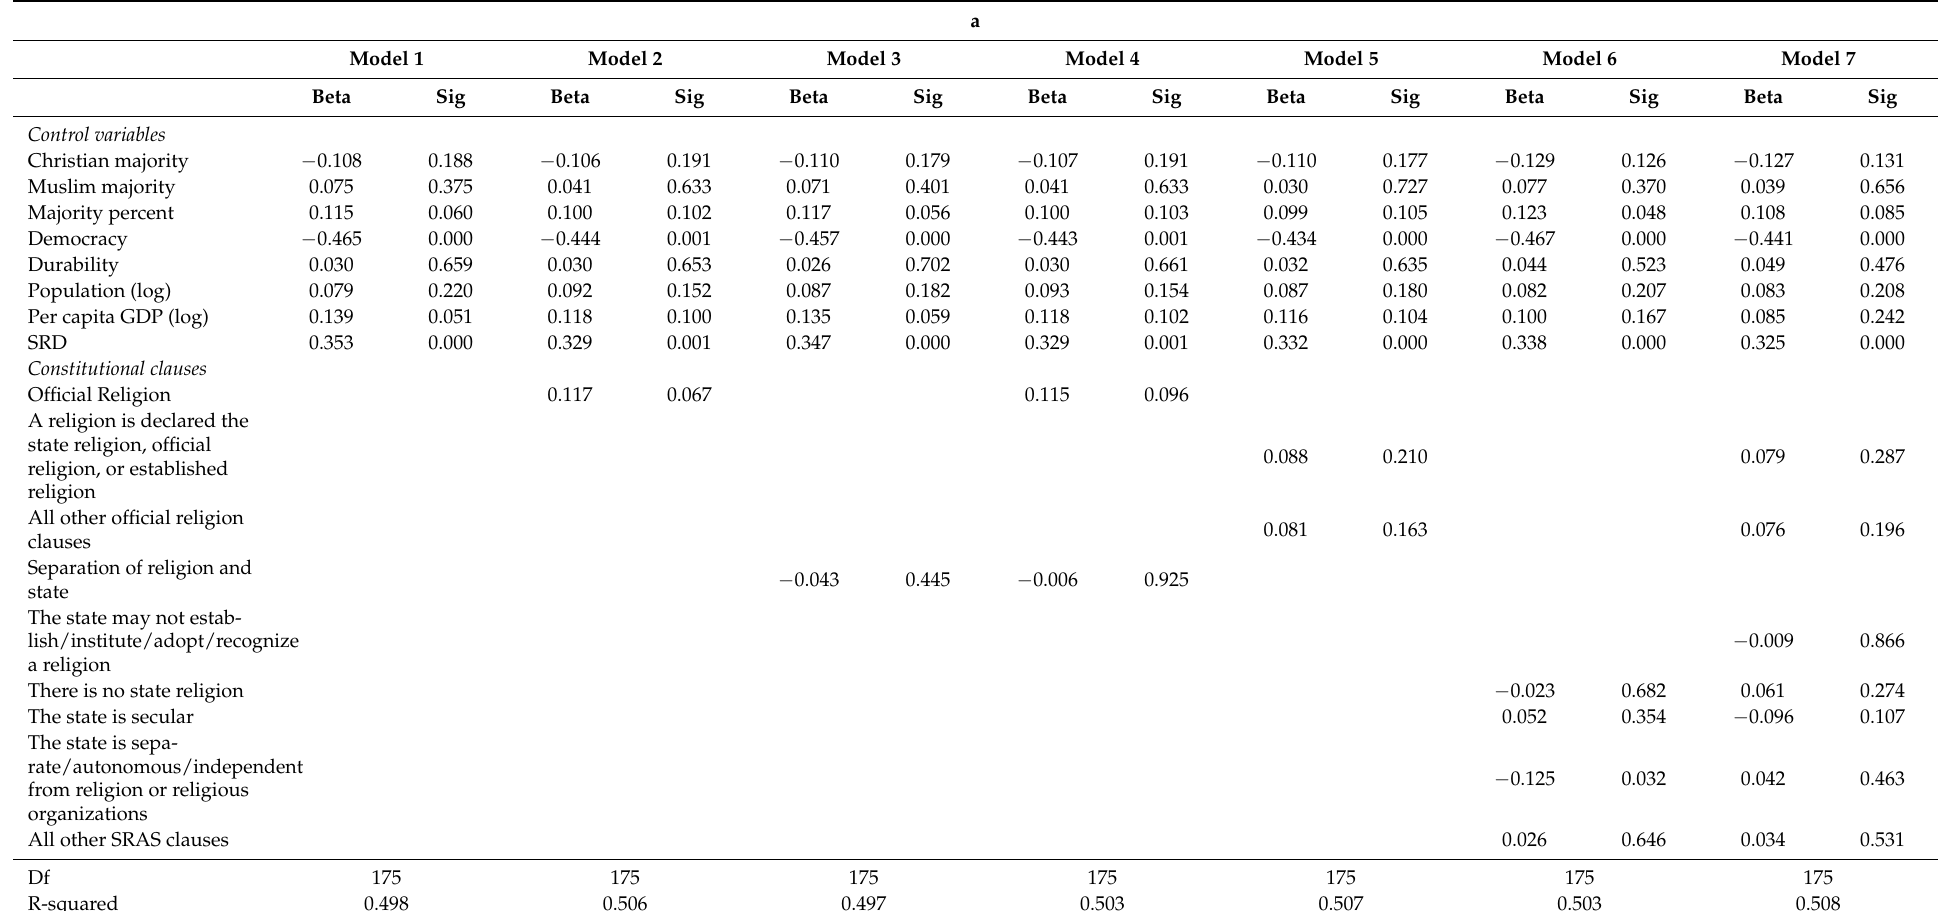
Table 2. a: OLS regressions predicting GRD in 2014 examining the impact of official religion and SRAS constitutional clauses; b: the influence of specific SRAS clauses on GRD in